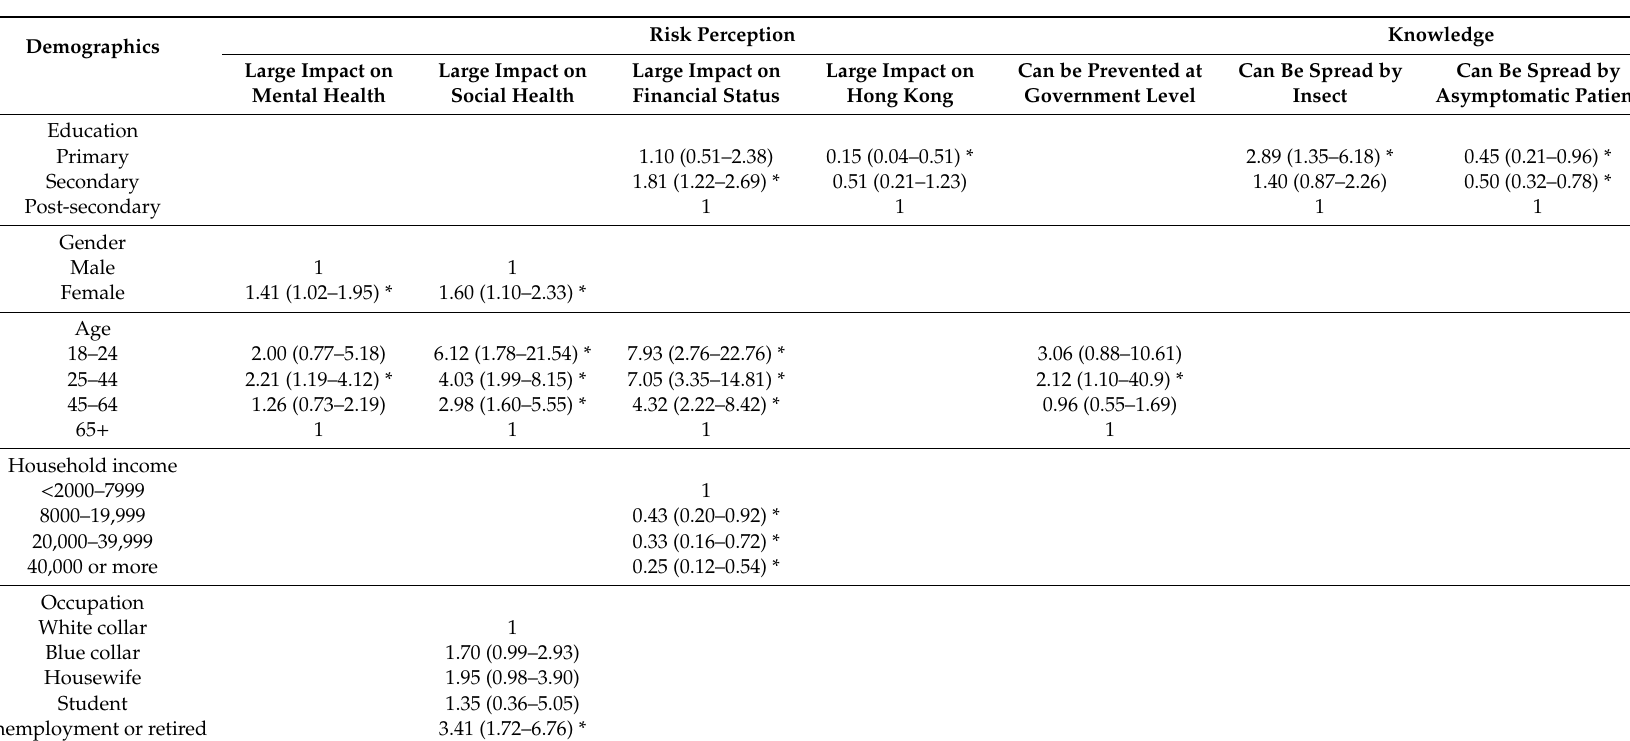
Table A1. Association between demographic variables and risk perception and knowledge about